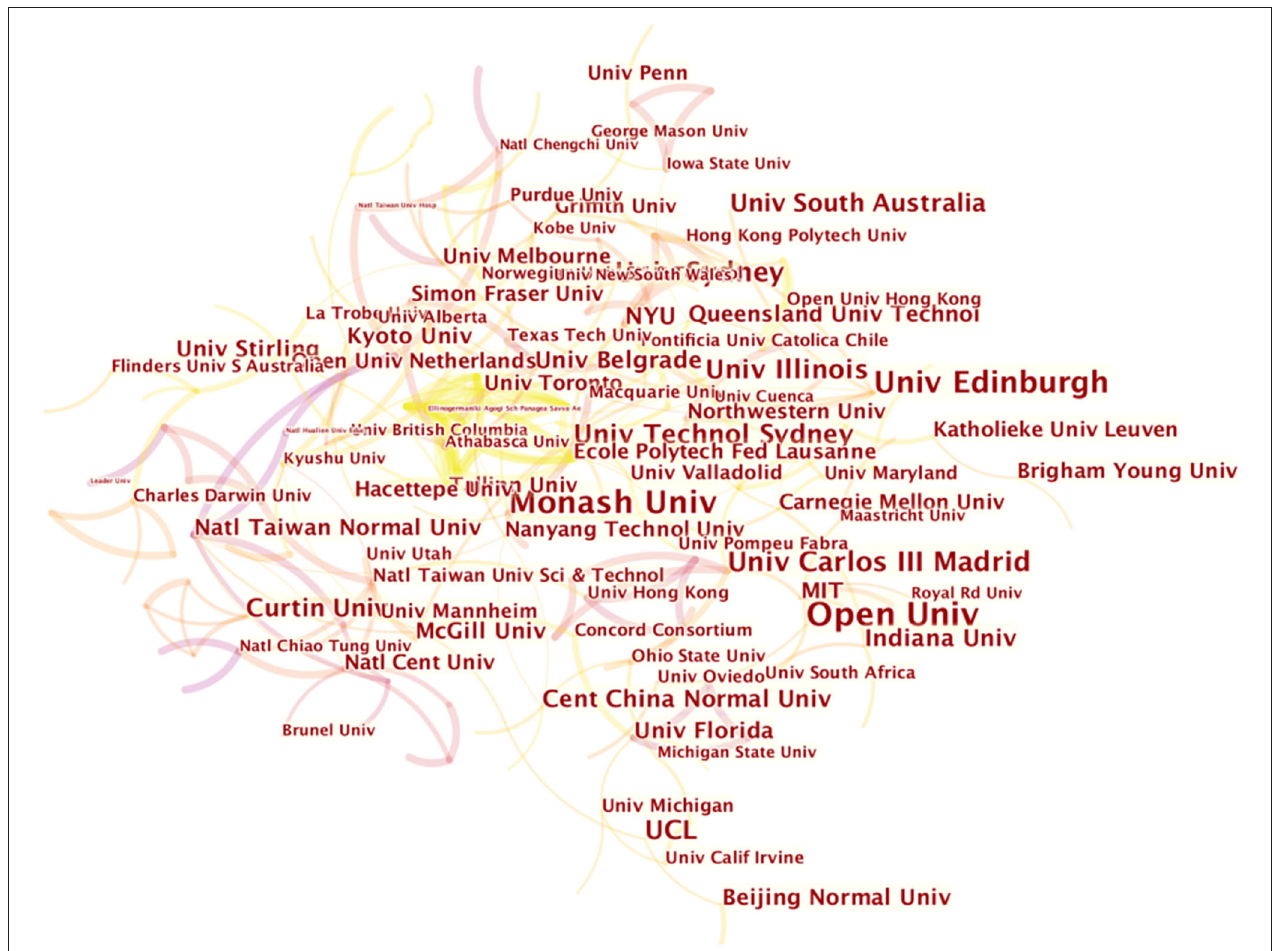
FIGURE 3 | Institution co-occurrence network of big data in education.